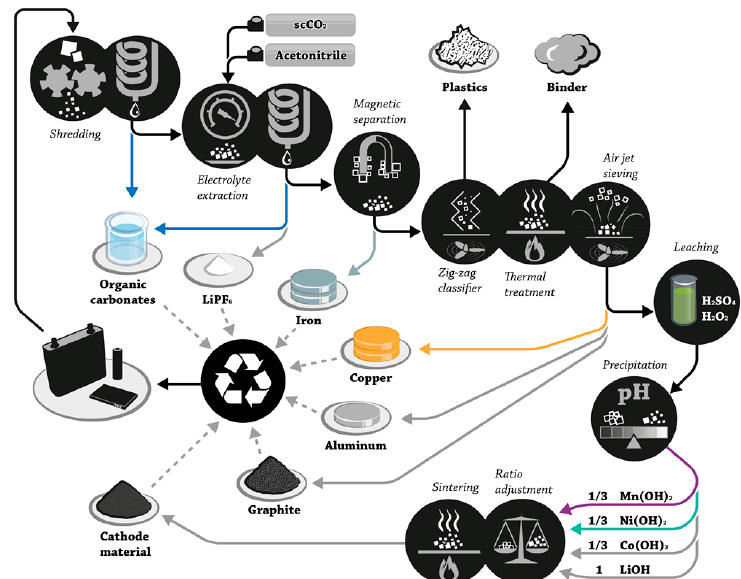
Figure 4. The mechanical-hydrometallurigcal “LithoRec II” recycling process. It was reproduced from reference [127], with permission from John Wiley & Sons 2016. scCO 2 : supercritical carbon dioxide.